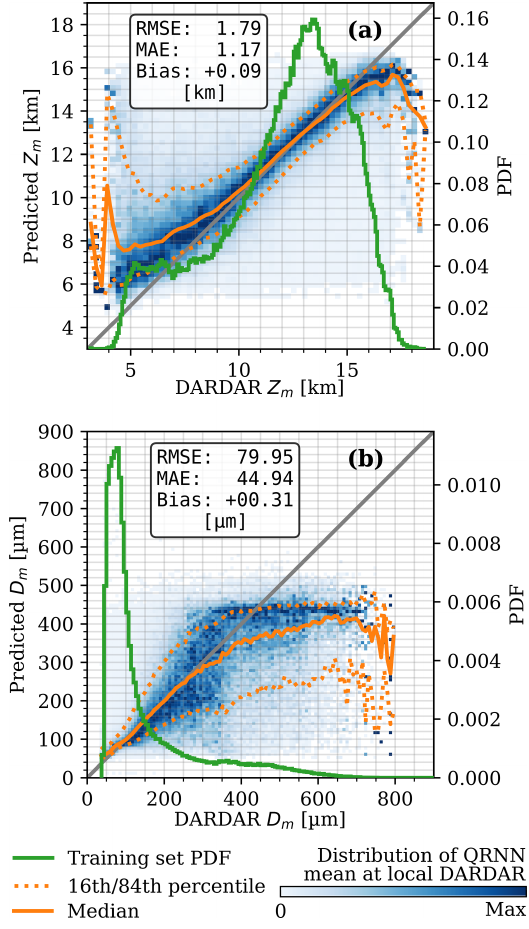
Figure 8. Predictions of Z m (a) and D m (b) with the CNN for the test set and training set PDF. Networks trained with both daytime and nighttime observations. Statistics plotted by the orange curves derived from the distributions indicated by the colour bar.